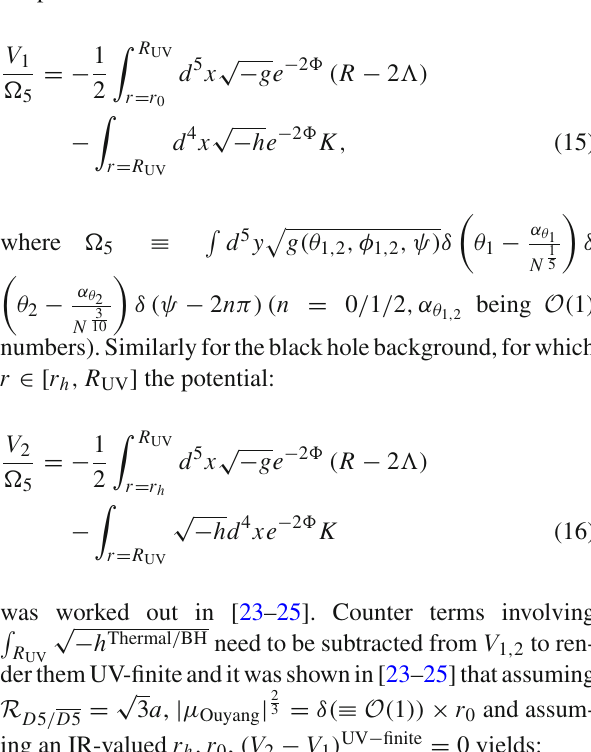
will when evaluated near θ 1 ∼ N − 1 5 , θ 2 ∼ N − 3 10 [the